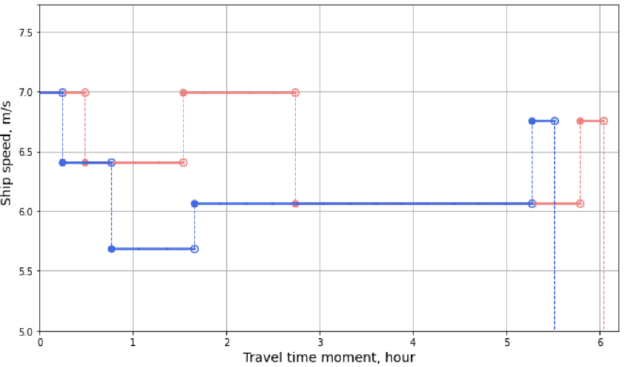
Figure 5. Ship speed in time for routes shown with green in Figure 4e (red line) and Figure 4f (blue